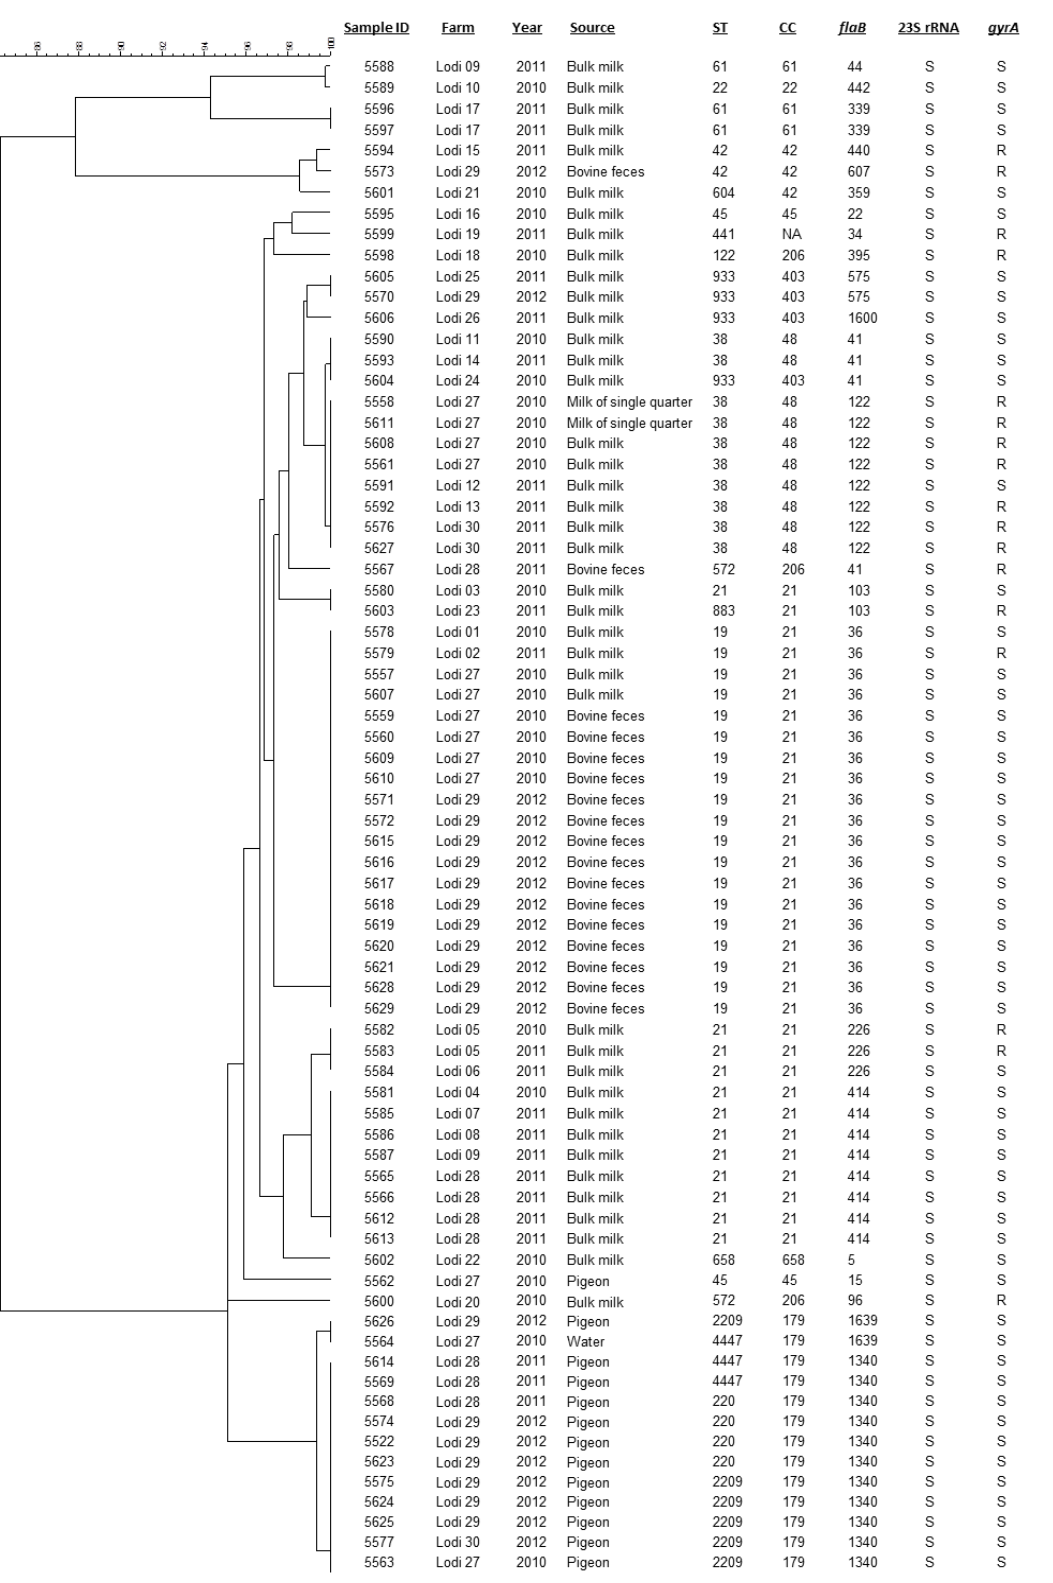
Figure 1. Clustering of the strains based on the partial flaB gene sequences. The UPGMA tree was constructed in BioNumerics. For each strain are indicated: farm, year and source of isolation; MLST (ST and CC) and flaB type; the susceptibility (S) or resistance (R) to macrolides (23S rRNA) and quinolones ( gyrA